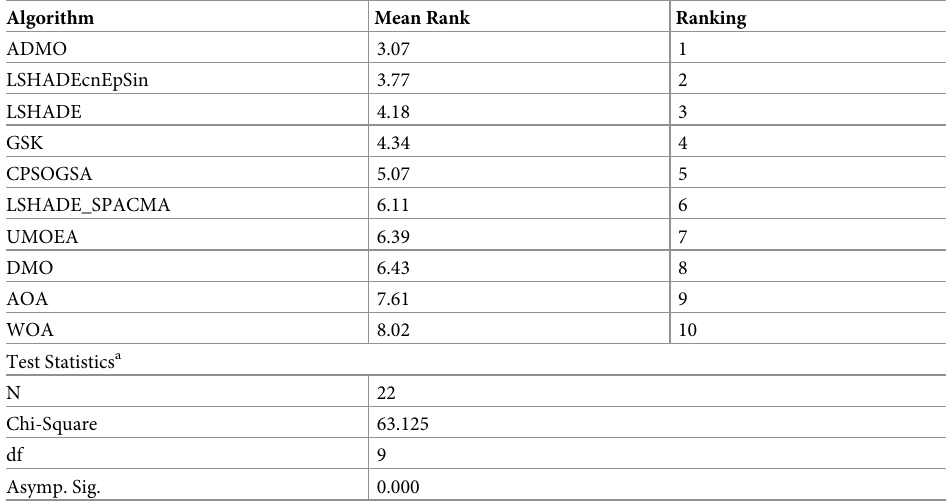
Table 18. Friedman’s test results.